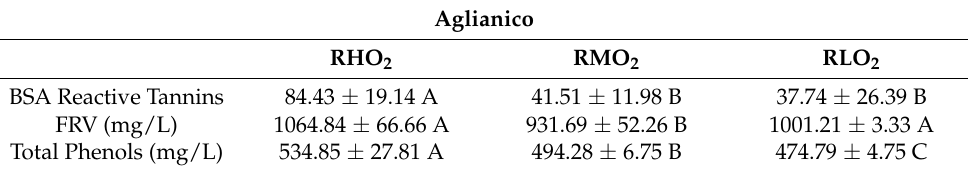
Table 6. Total phenols, flavans reactive to vanillin and tannins reactive to